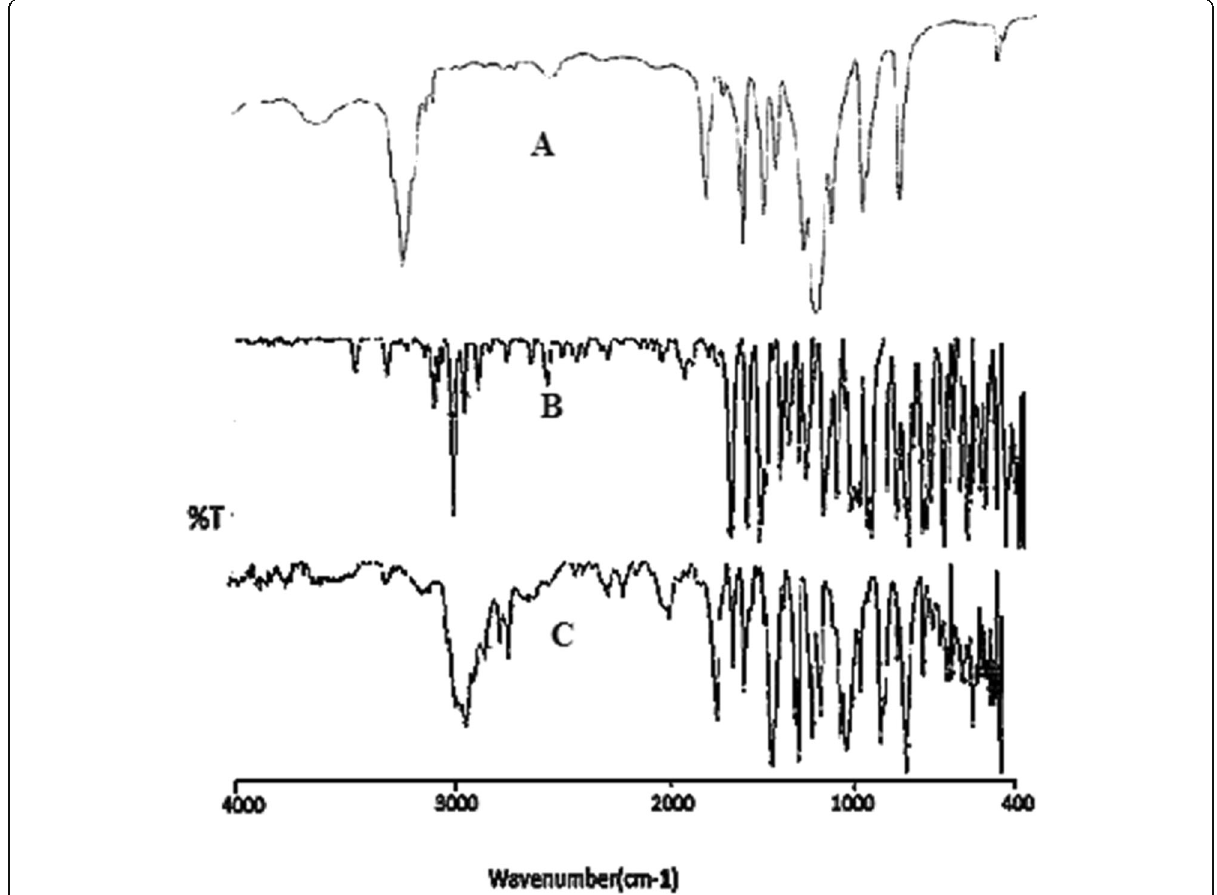
Fig. 5 FT-IR spectra of ( a ) PEG 4000 ( b ) Pure Fenofibrate ( c ) Fenofibrate